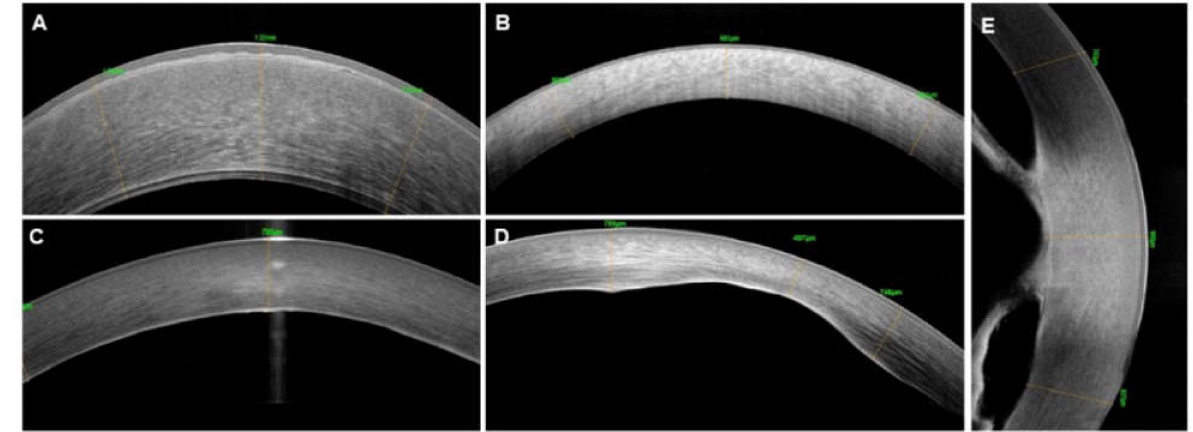
Figure 6. Anterior segment optical coherence tomography images of various corneal conditions. Congenital hereditary endothelial dystrophy (CHED)—a thickened epithelial layer with underlying irregular bowman’s membrane, increased stromal thickness and abnormally thickened Descemet’s membrane ( A ); Hurler’s syndrome—a thickened corneal stromal layers and hyperreflective stroma ( B ); posterior polymorphous corneal dystrophy (PPCD)—abnormal thickening and hyperreflec- tive Descemet’s membrane ( C ); Peters Anomaly—posterior corneal defect ( D ); and kerato-irido- lenticular contact ( E